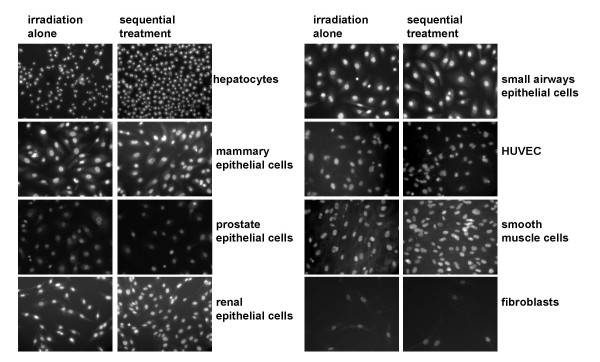
Microscopic evaluation of normal tissue cells. Lack of apoptosis was determined by microscopic evaluation of Hoechst stained cell nuclei. Micrographs depict cells of eight different normal tissues, 48 h after irradiation alone and after sequential treatment with 10 Gy 12 h previously to application of 1,0 ng/ml TRAIL.